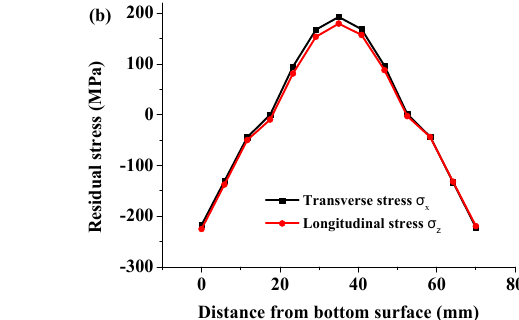
Figure 6. Residual stress distribution of quenched T-type rib: ( a ) path ab; ( b ) path cd (depicted in Figure 3).